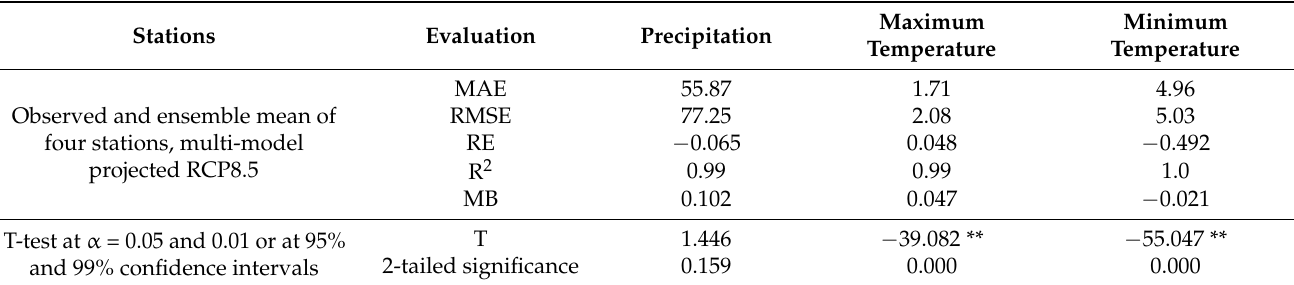
Table 2. Computed performance statistics results based on the bias correction method and T-tests. Asterisks (**) indicate that both the maximum and minimum temperature changes are statistically significant at both the α = 0.01 and 0.05 significant